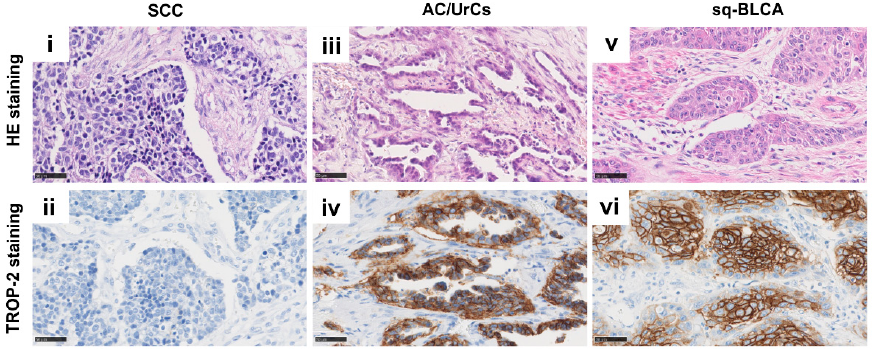
Figure 4. HE and immunohistochemical anti-TROP-2 staining of SCC ( i , ii ), AC/UrCs ( iii , iv ), and BLCA ( v , vi ) tissues, respectively. Scale bar: 50 µm. sq-BLCA ( v , vi ) tissues, respectively. Scale bar: 50 µ